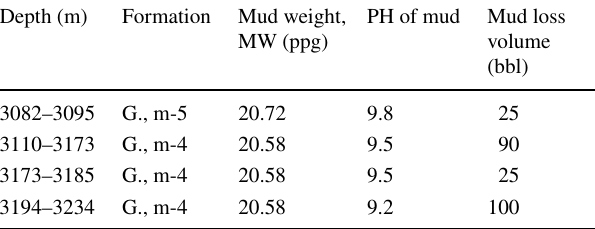
Table 7 Kick flow occurrence data (in member-5 of Gachsaran formation in well Z26)